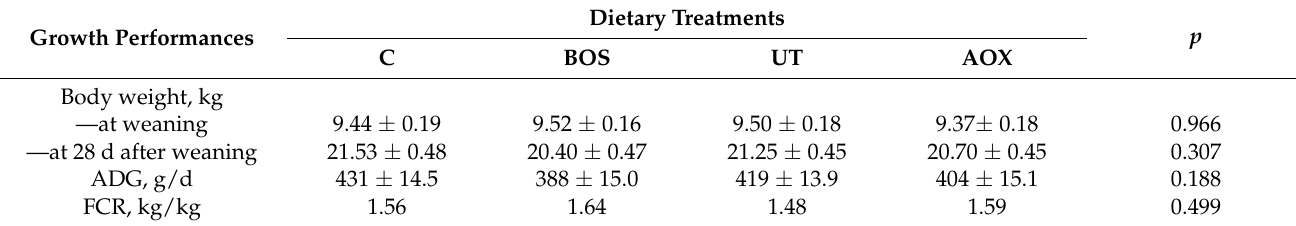
Table 2. Growth performances of piglets fed the control diet (C) and the diet supplemented with B. serrata extract (BOS), U. tomentosa and T . parthenium extract mixture (UT), and the plant extract mixture (AOX). Dietary Treatments Growth Performances